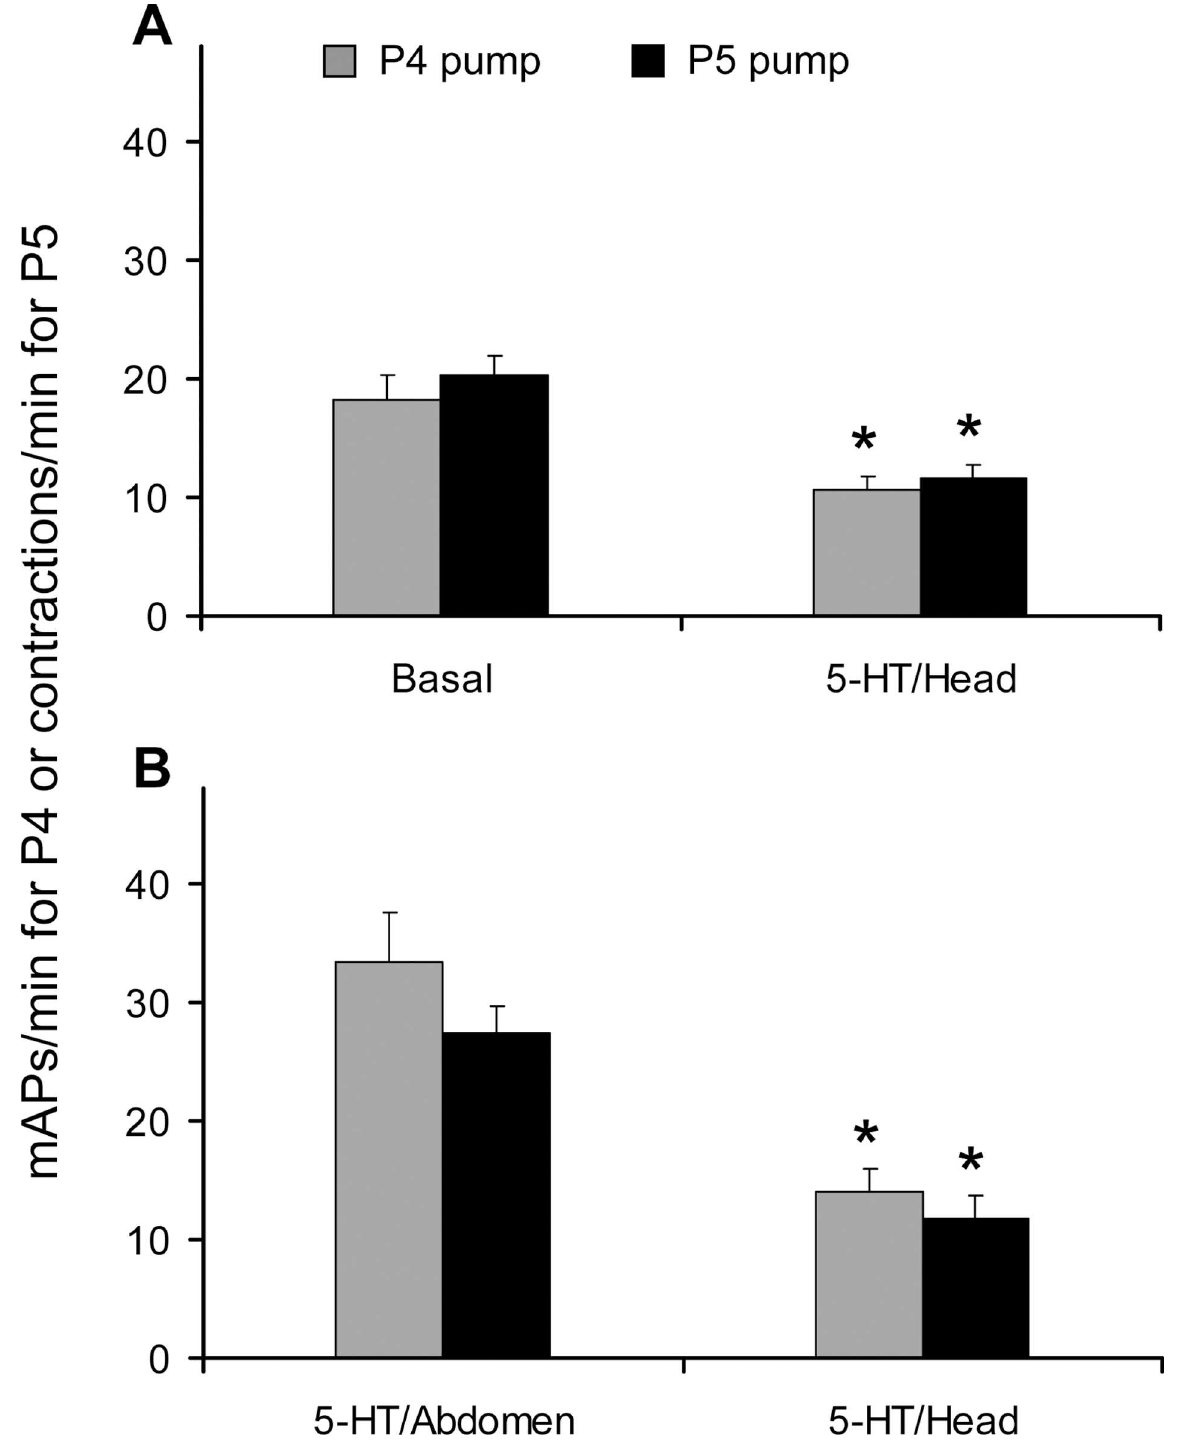
Fig 8. Opposite effects of 5-HT injected into the brain vs . perfusion application on the crop. Frequency of mPAs, electrophysiologicallyrecorded from P4 and of contractions visually recorded from P5 in Drosophila Canton-S strain, determined over a 1-min interval, followinginjectionof 5-HT into the brain as compared to the activity in Drosophila saline (basal) (a) or to the activity previouslyenhancedby perfusion application of 5-HT into the abdomen. Mean values ± SE (vertical bars) from 15 replicates in (a) and 16 replicatesin (b). The asterisk indicates a significant difference(P < 0.05; Tukey test subsequent to repeated-measures ANOVA) with respect to the basal level.